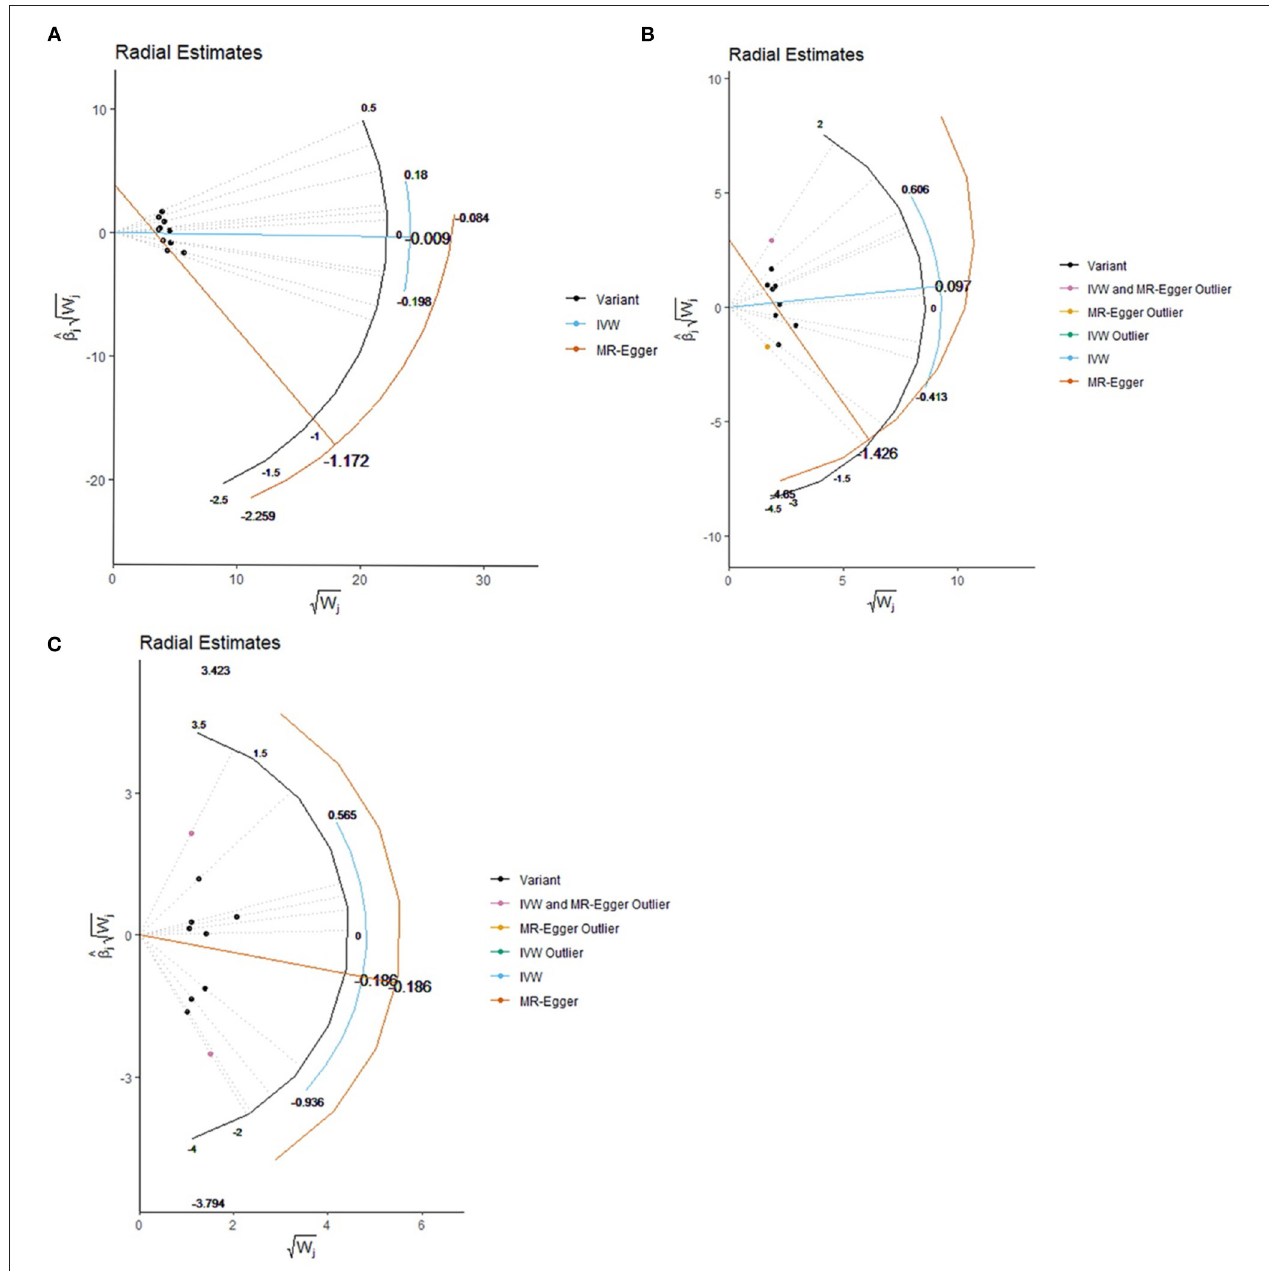
FIGURE 2 | Effect estimate for each individual variant via the radial plot and radial regression. (A) COVID-19 susceptibility, (B) COVID-19 hospitalization, (C) COVID-19 severe disease. IVW, inverse variance weighted.